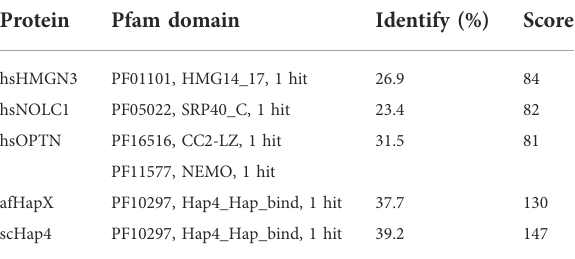
TABLE 3 Sequence comparison of spPhp4 to its sequence homologs in A. fl avus , H. sapiens , and S. cerevisiae . Protein